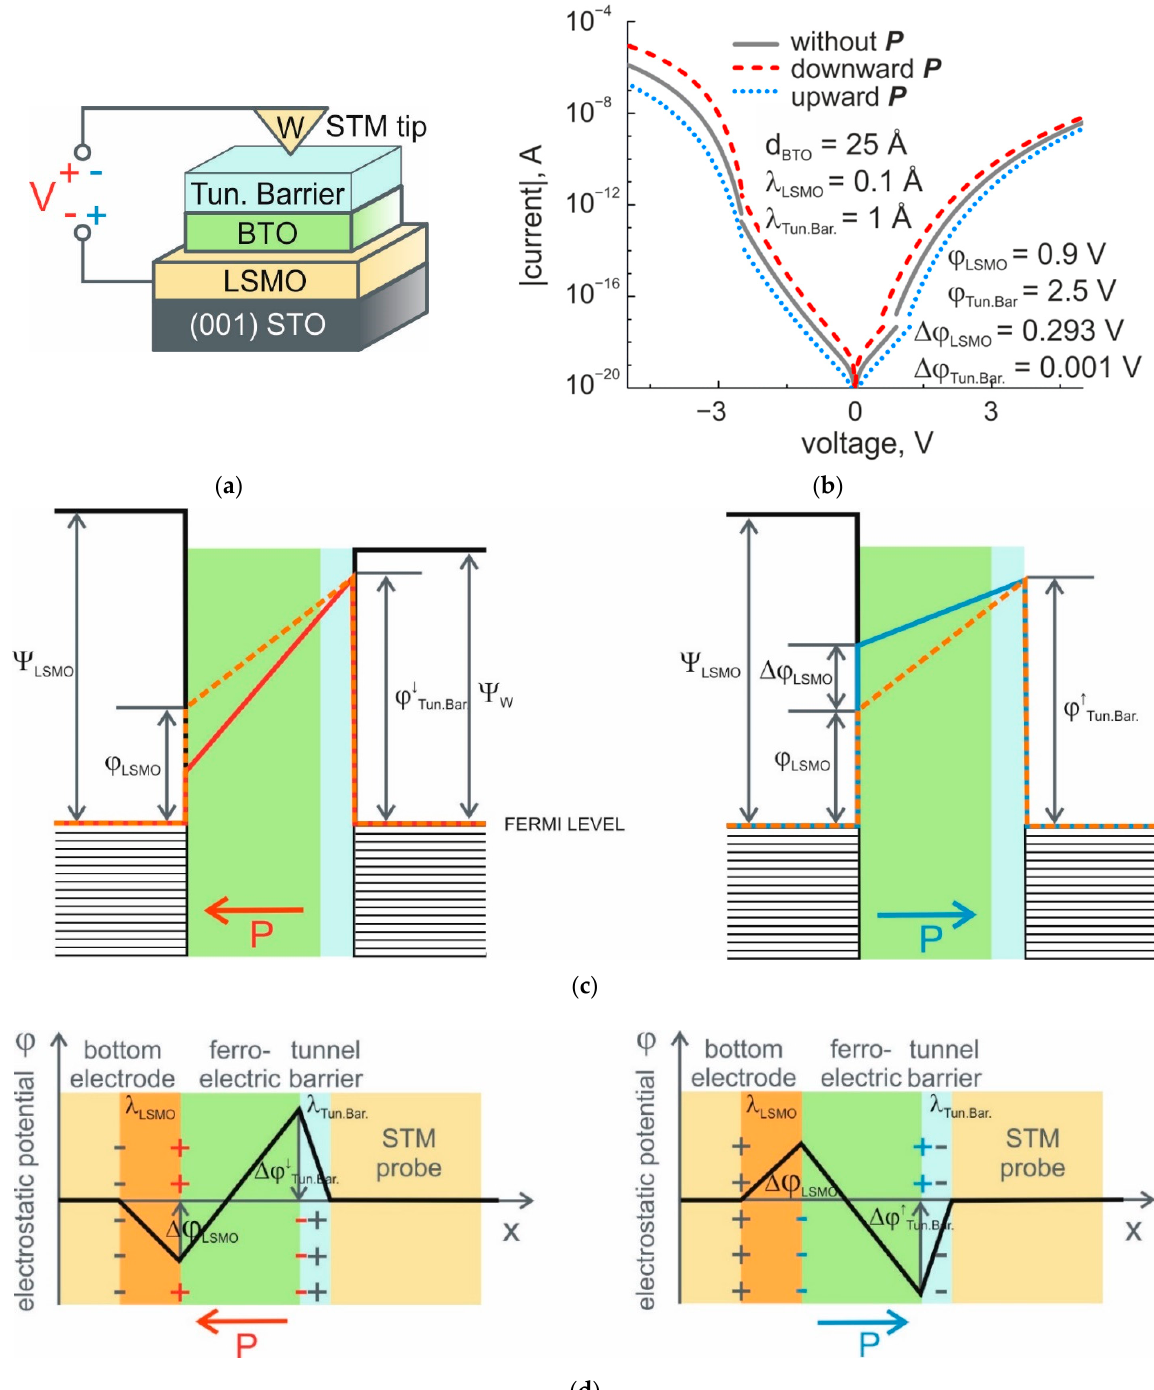
Figure 4. STM study of TER. ( a ) Schematic illustration of a STO/LSMO/BTO FTJ and a method for investigation of the resistive properties with STM tip; ( b ) simulated I-V curves of FTJs in case of STM measurements. The simulation is based on the imperfect screening of polarization charges at the interface with bottom electrode and the Simmons approach for intermediate and high-voltage ranges; ( c ) energy diagram of the barrier consisting of thin FE film and STM tunnel gap between the bottom electrode of the structure and the STM tip at different polarization orientations; ( d ) schematic representation of the residual uncompensated potential, φ (x), for uniformly polarized FE film between bottom electrode and STM tip with effective screening length, λ LSMO , and width of a tunnel gap, λ Tun.Bar. , for two polarization states. Left to right: for polarization pointing to the left and for polarization pointing to the right.